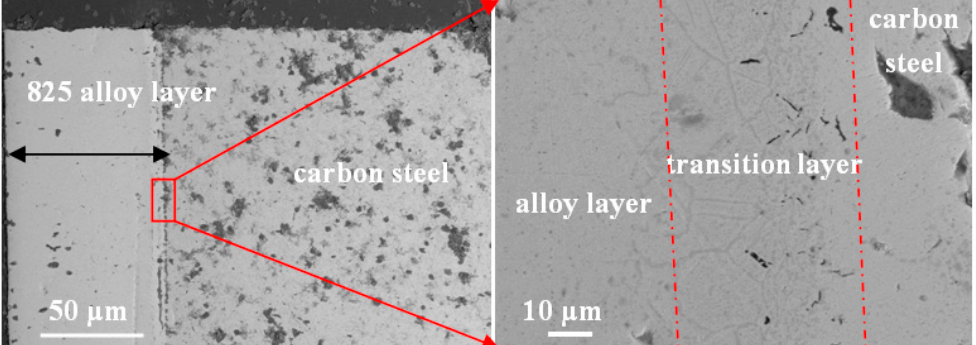
Figure 3. SEM images of duplextube. Table 3. Chemical composition of Incoloy 825 alloy